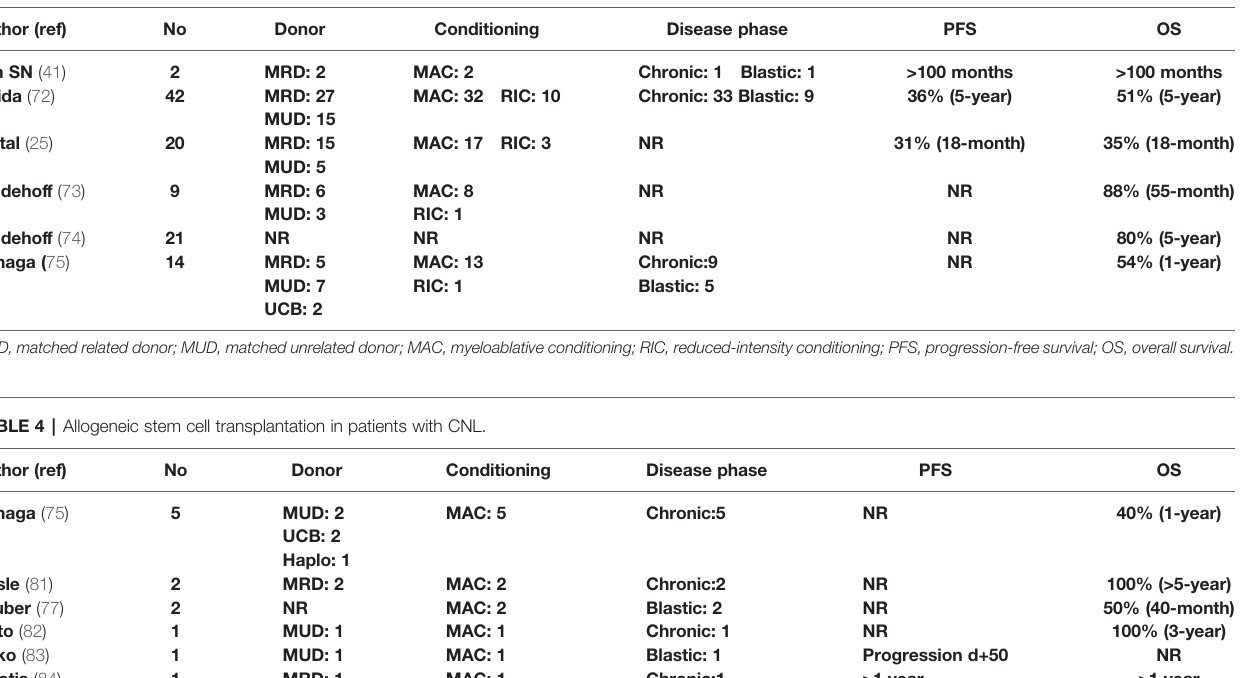
TABLE 3 | Allogeneic stem cell transplantation in patients with atypical CML.